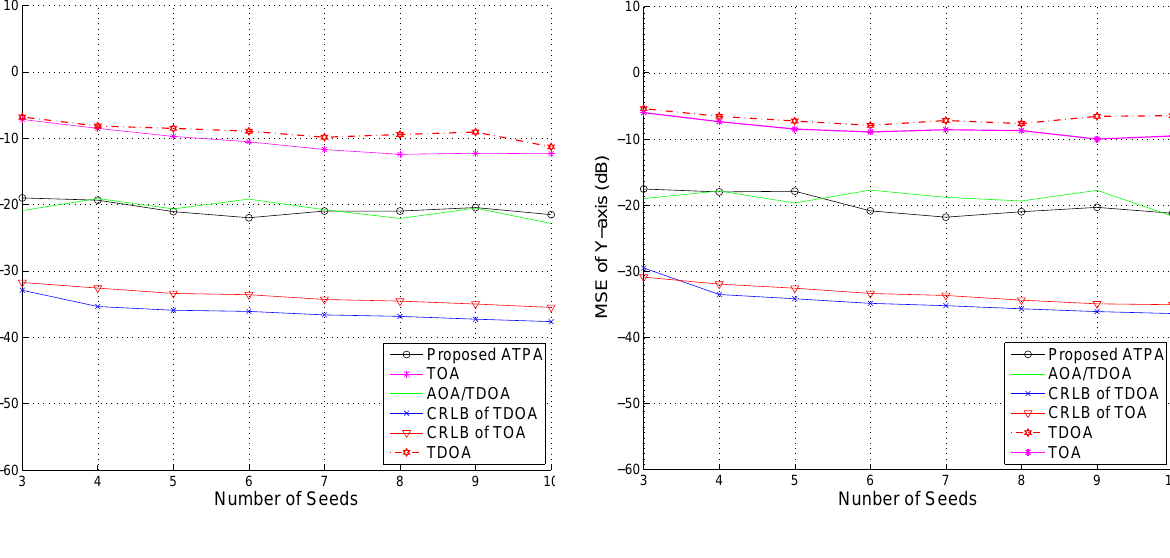
Figure 12. The effect of number of seeds on estimation